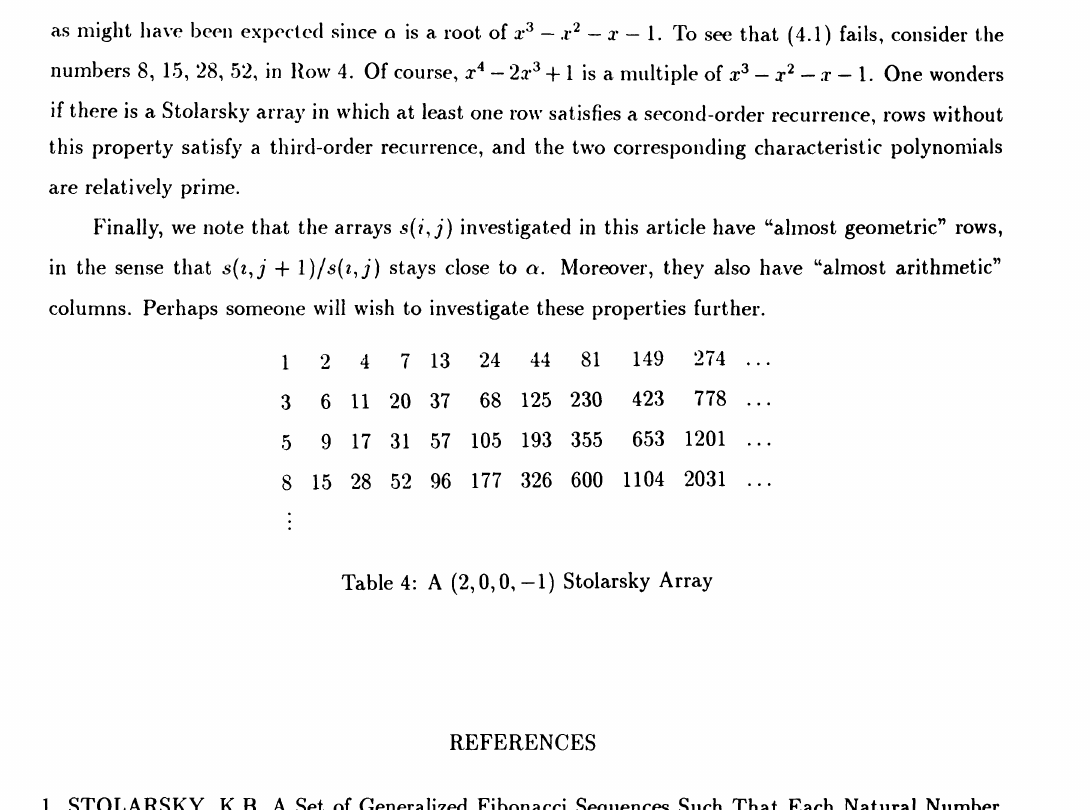
Table 4: A (2, 0, 0, -1) Stolarsky